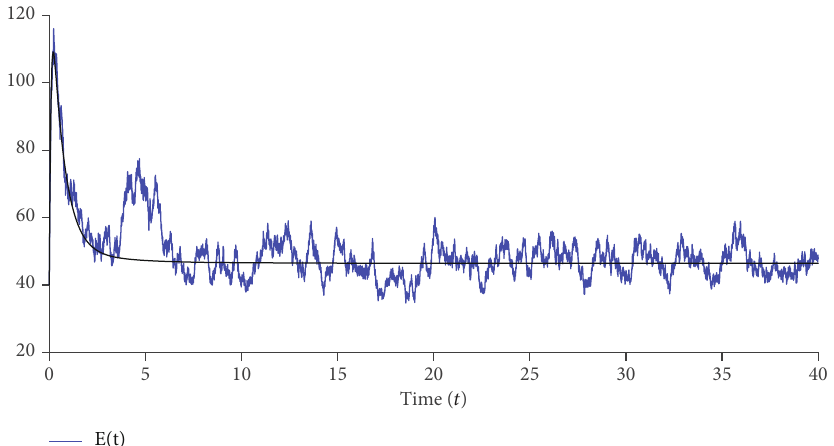
Figure 3: Dynamical simulation of E ð t Þ for the deterministic system (1) and stochastic system (2) with the parameter ’ s value presented in Table 1 and noise parameter values: σ π ð α Þ = 0 : 01 5